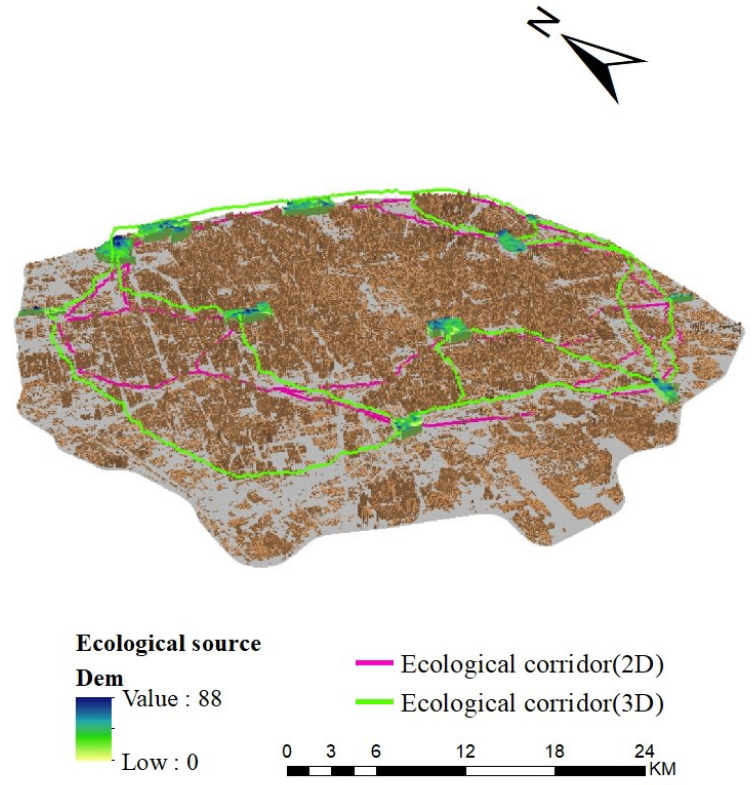
Figure 7. Two- and three-dimensional ENs.